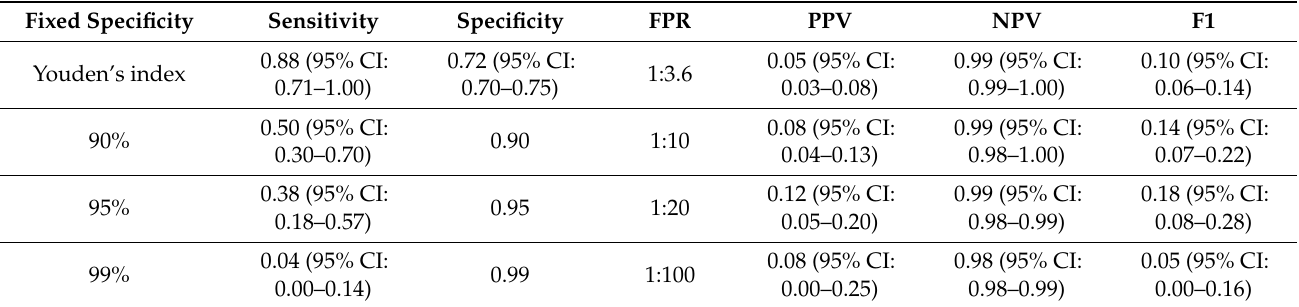
Table 3. Metrics of the final gradient-boosting